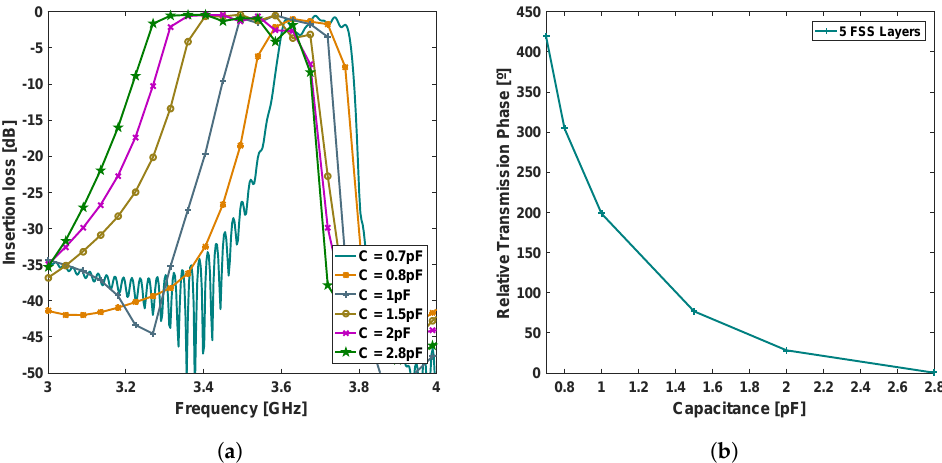
Figure 3. ( a ) Simulated S 21 and ( b ) relative transmission phase depending on inserted